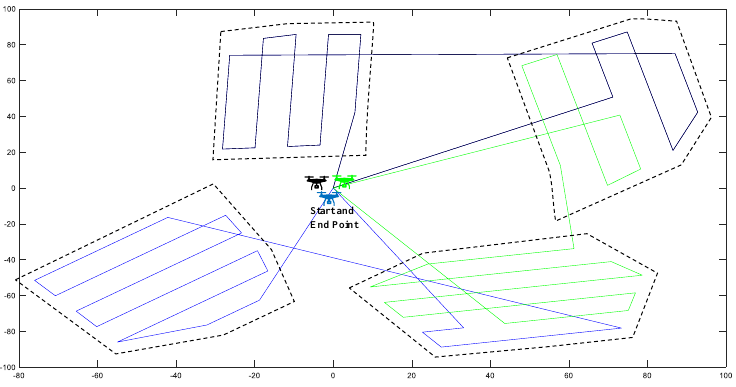
Figure 9. Powell-BINPAT task